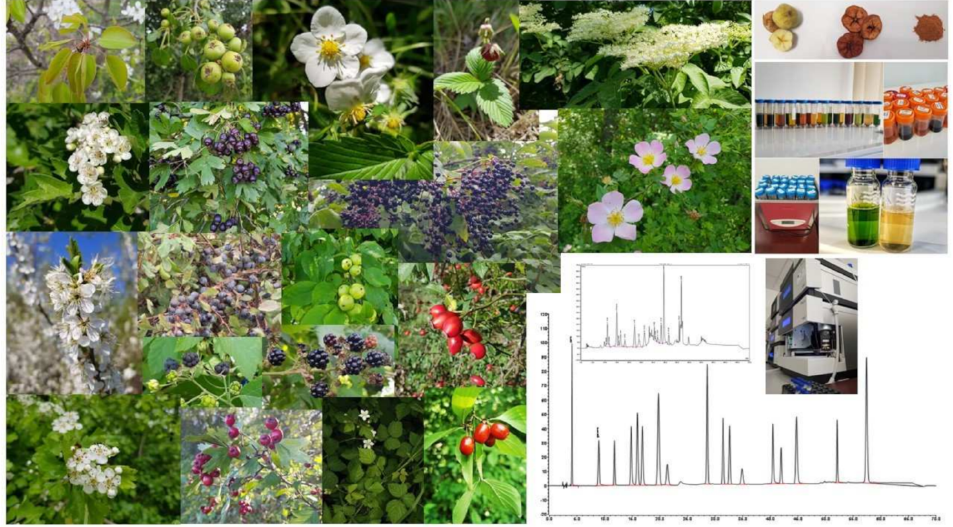
Figure 1. Diagram of the plant materials used and the general